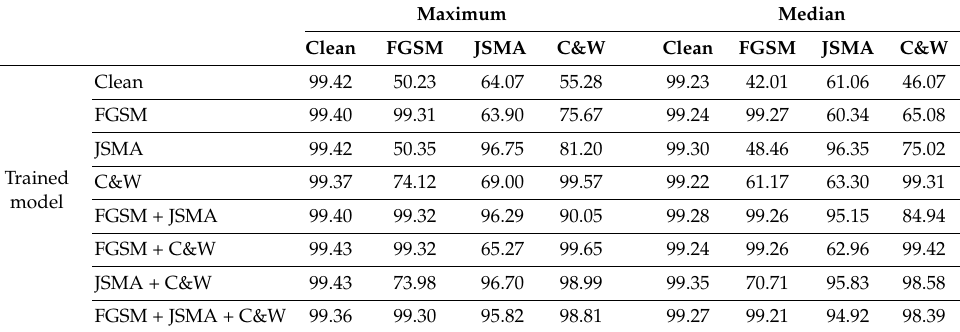
Table 2. Test accuracy of LeNet5 measured between 20 and 50 epochs. The network is trained with data augmentation including random rotation, random translation and random erasing.